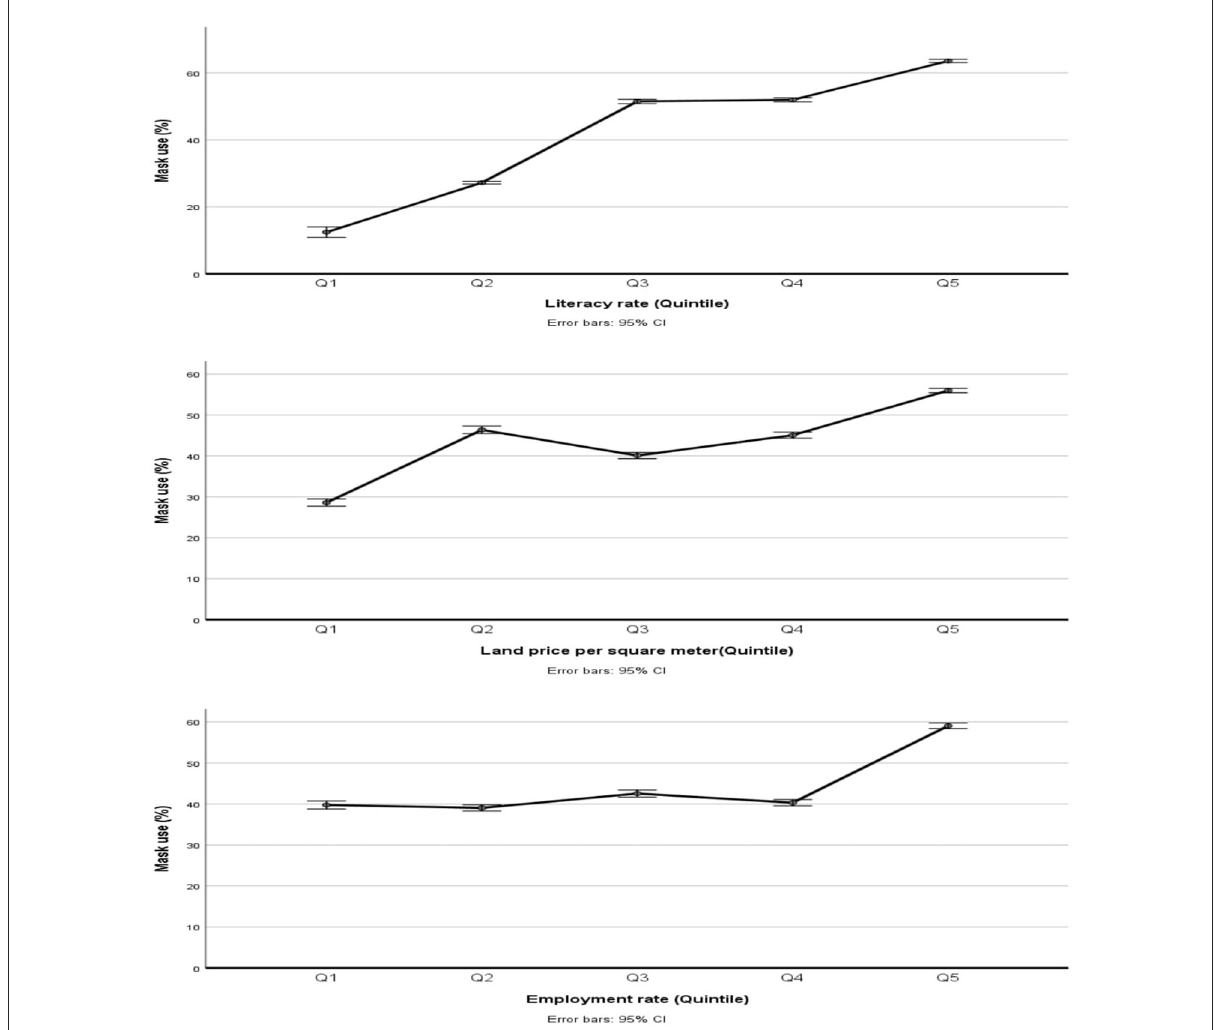
FIGURE2 Comparison of the prevalence rates of mask usage among quintiles of the SES indicators, adjusted for age and